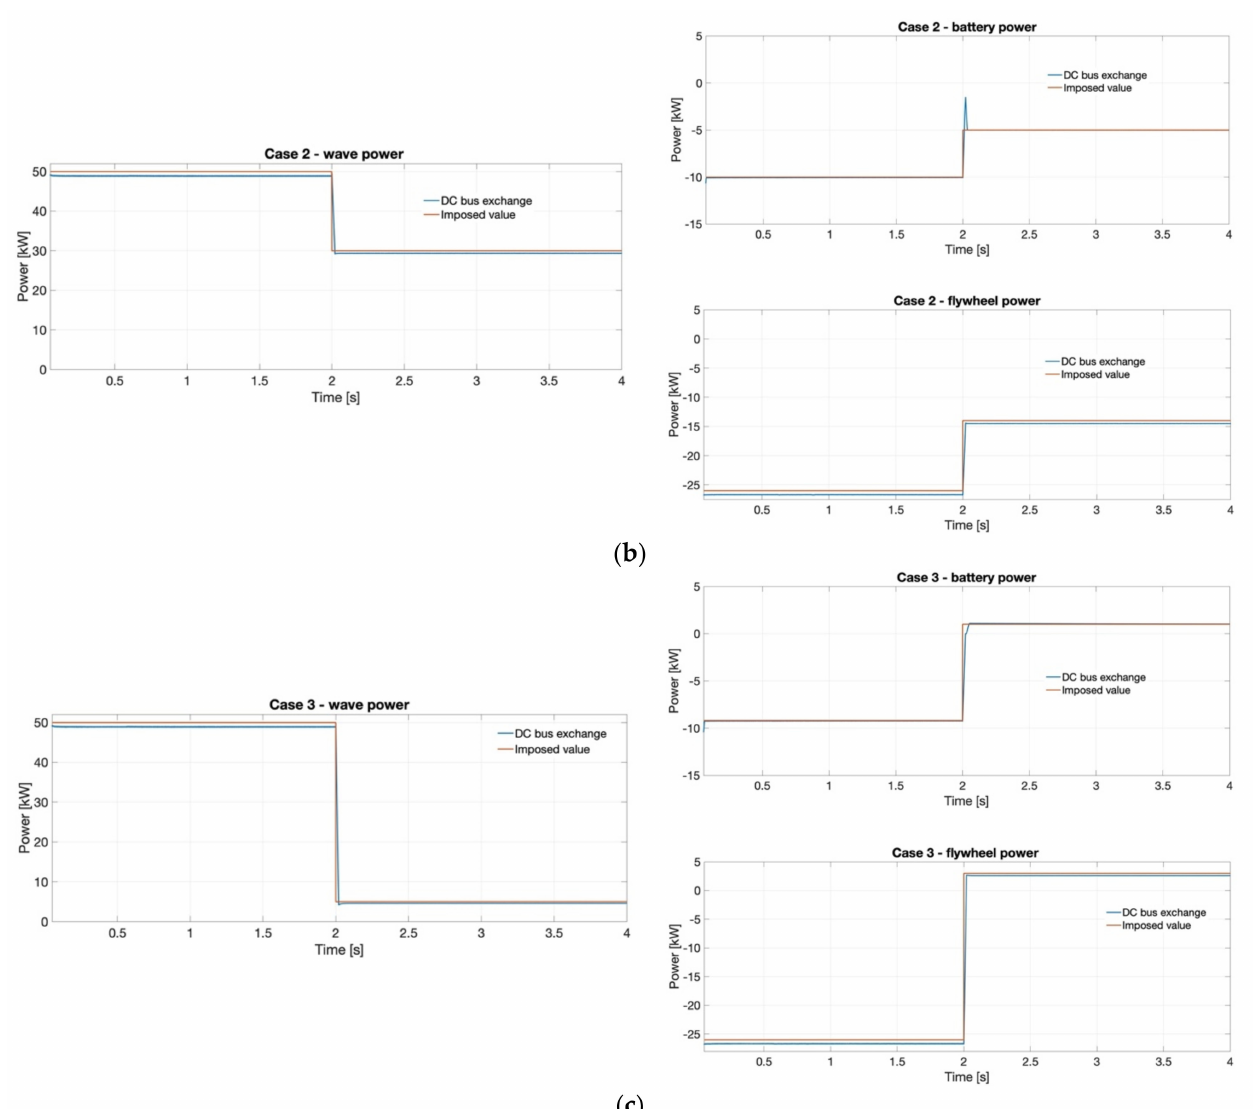
Figure 7. Wave power and HESS power (battery and flywheel power) for different case study: ( a ) Case 1, ( b ) Case 2 and ( c ) Case